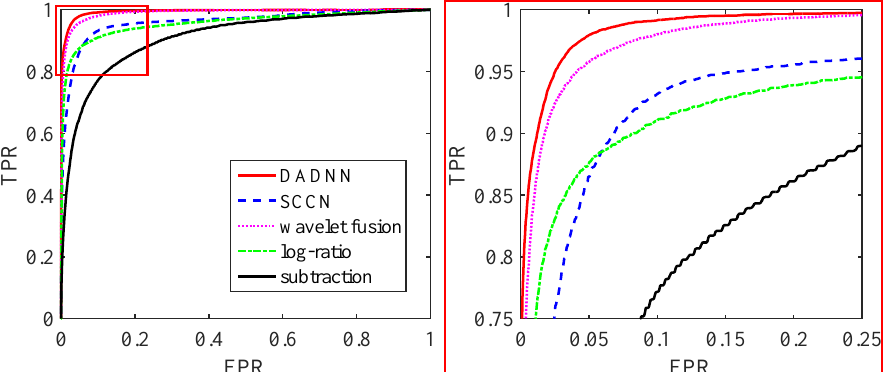
Figure 18. The ROC plots of the five difference maps on the Ottawa data set. The right shows corresponding enlarged areas of red boxes in the